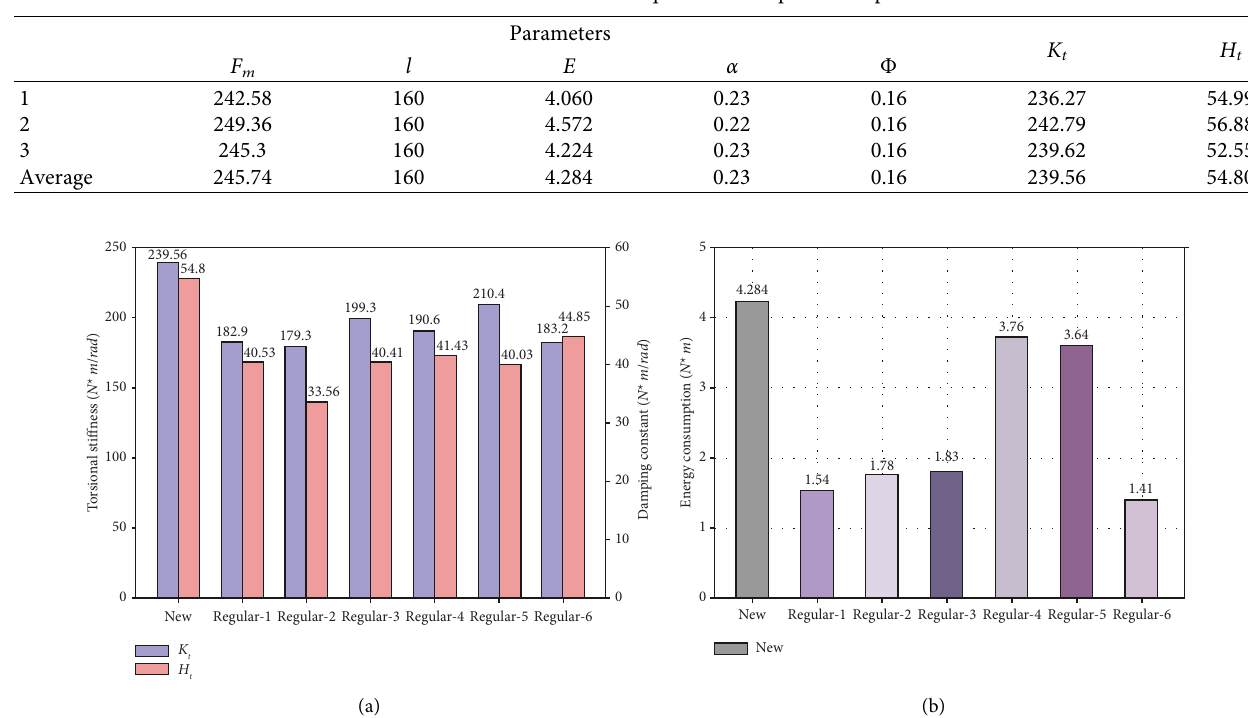
Table 3: Test data of the new quad-bundle spacer